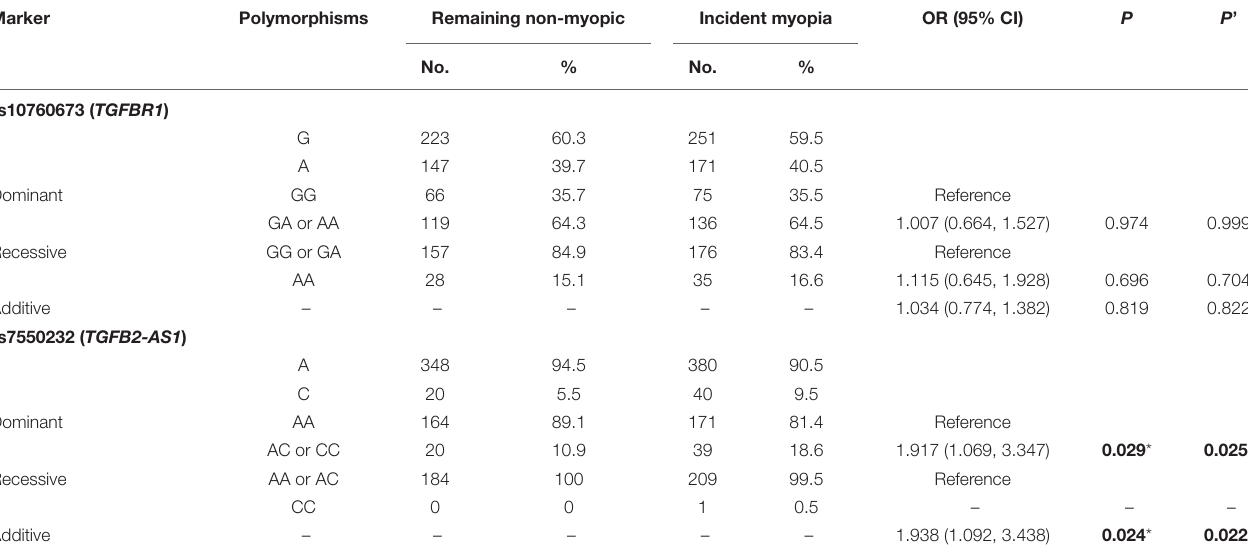
TABLE 3 | Associations between genetic polymorphisms and the onset of myopia in various genetic models.